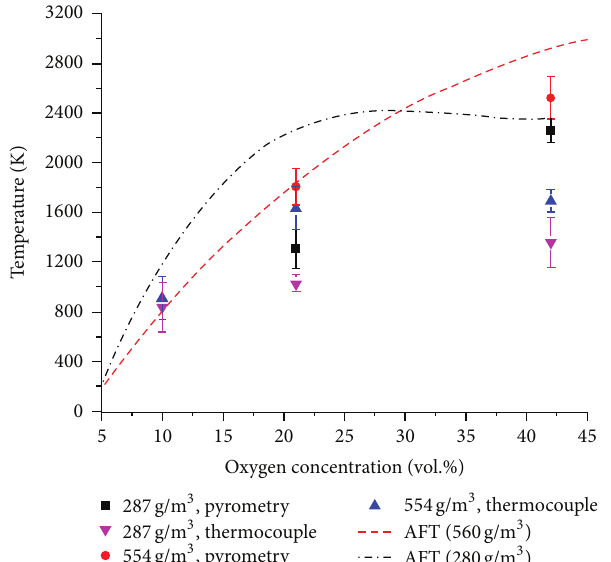
Figure 13: Flame speed measurements by analysis of pressure-time data for sulfur dust